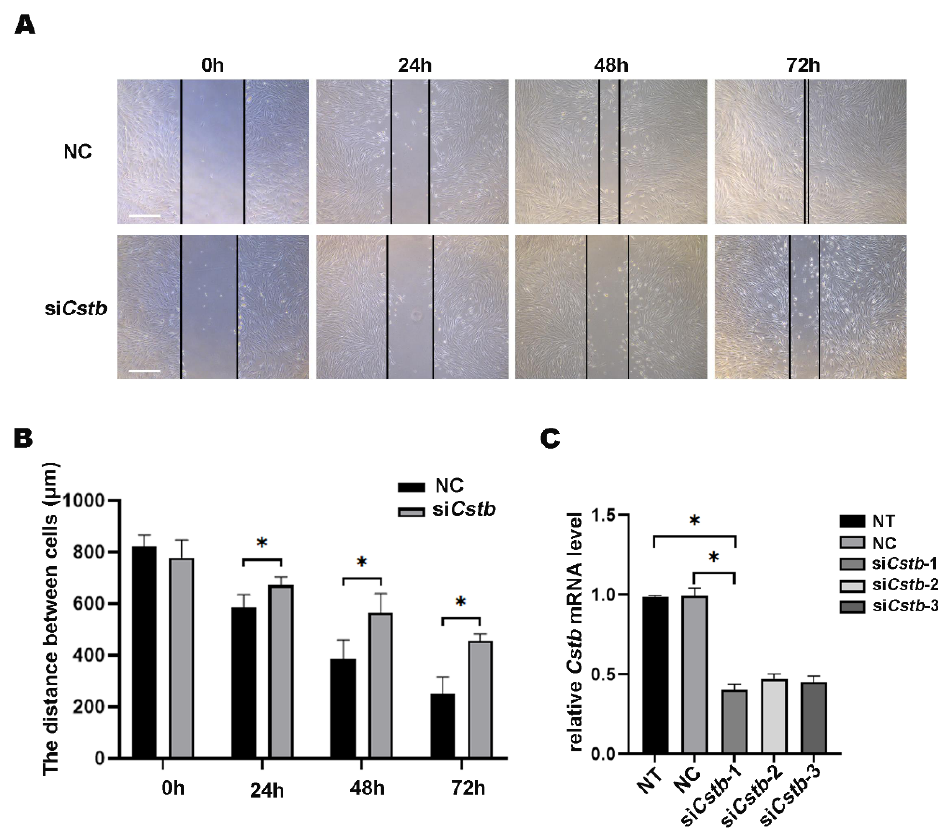
Figure 4. Cstb regulates the migration of mouse uterine stromal cells. ( A ) Stromal cells treated with siRNA were examined for wound closure 72 h after a wound scratch was made. Live cell images were captured at 0 h, 24 h, 48 h, 72 h. Bar = 400 μ m. ( B ) Distance between stromal cells treated siRNA was examined. ( C ) The expression of Cstb in stromal cells treated with siRNA was detected by